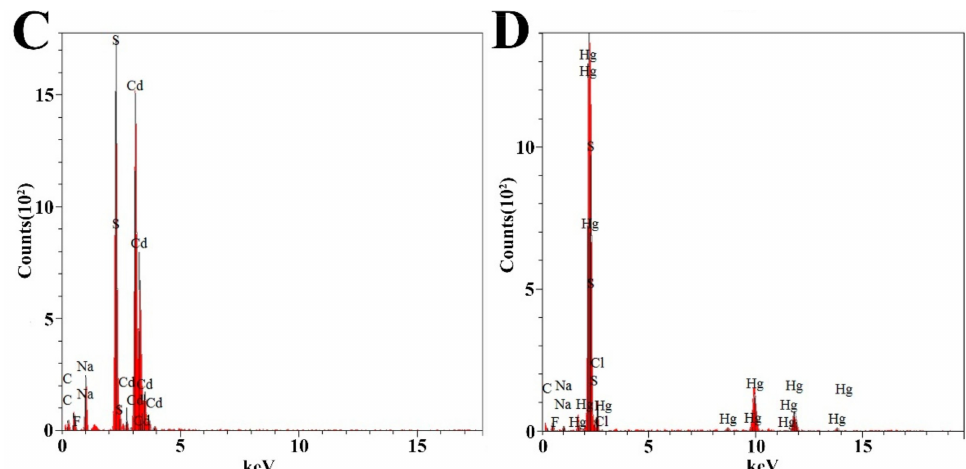
Figure 4. Energy-dispersive spectrometry spectra of the precipitates formed by P. cashew SRB007 when cultured in the medium containing different concentrations of Co 2+ ( A ), Ni 2+ ( B ), Cd 2+ ( C ) and Hg 2+ ( D ), respectively.